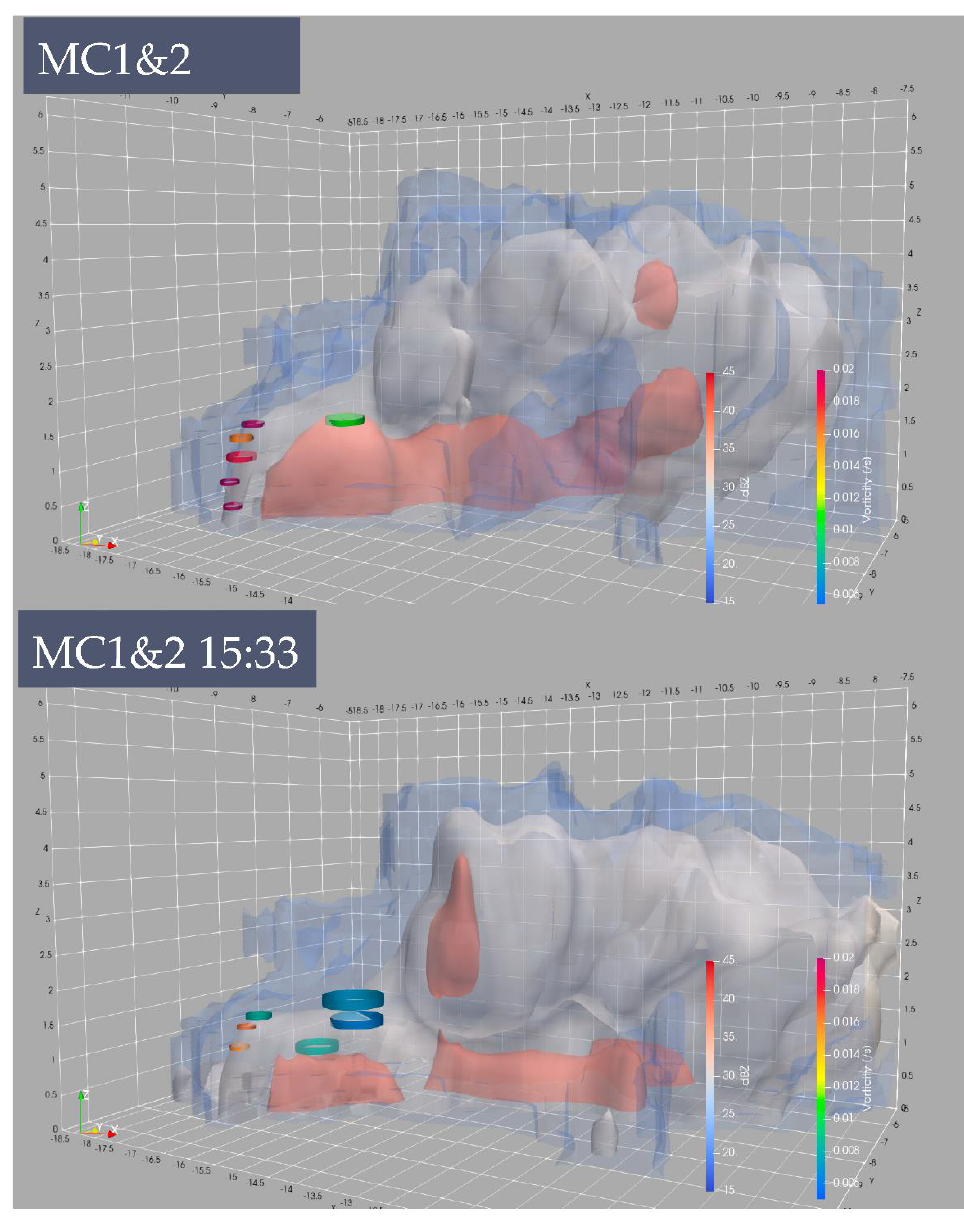
Figure 7. Same as Figure 4 except for side view from southeast at 15:27, 15:29, 15:31 and 15:33 JST.